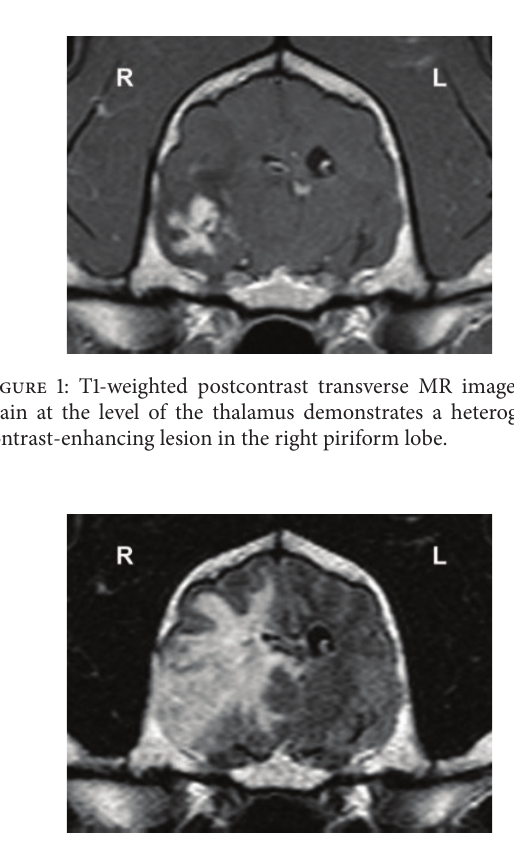
Figure 2: FLAIR transverse MR image of the brain at the level of the thalamus shows hyperintensity throughout the right cerebral hemisphere, most consistent with marked perilesional edema. A midline shift to the left results in compression of the right lateral ventricle and